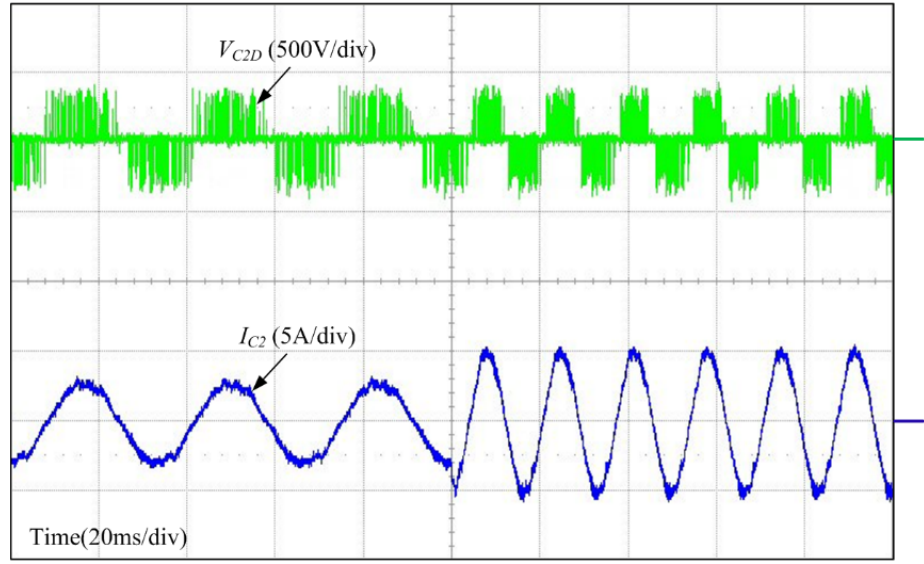
Figure 16. Experimental waveforms of the output line-to-line voltage and the output current for the single-phase